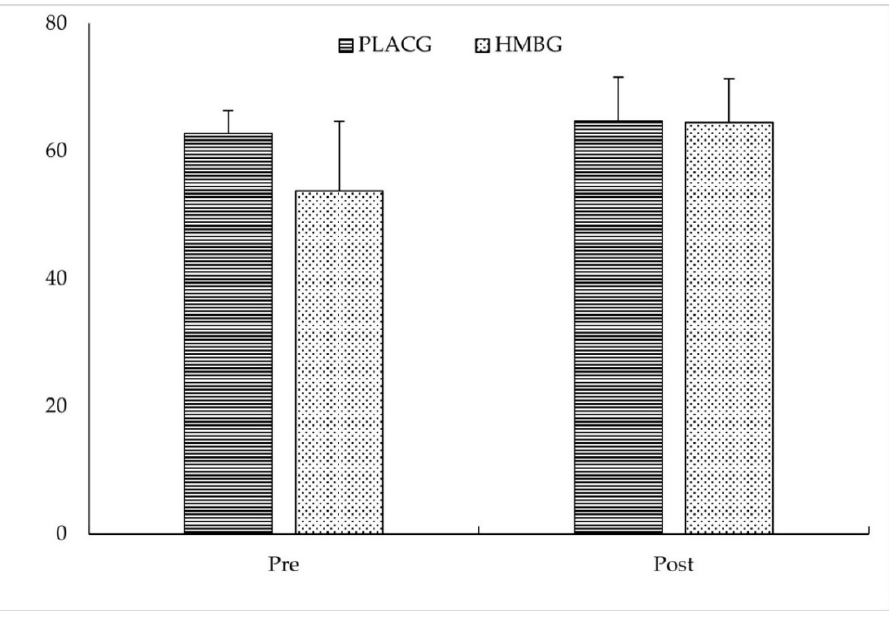
Figure 2. Subjective pain perceived by the VISA-P score. HMBG: β -Hydroxy β -methylbutyric group; PLACG: placebo group; VISA-P: Victorian Institute of Sport